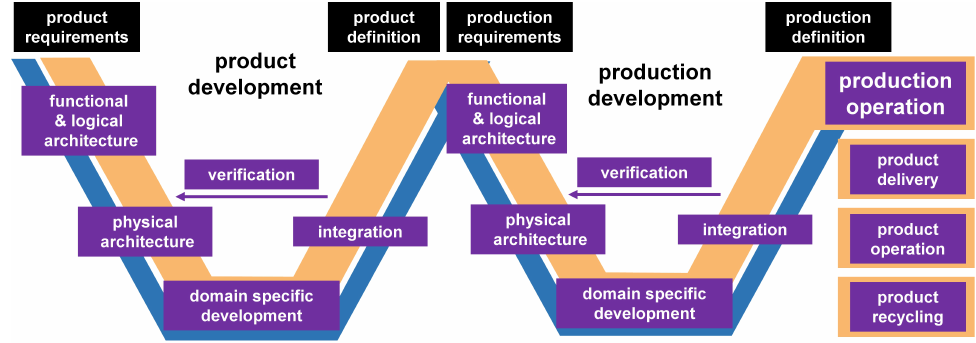
Figure 2. Life-cycle of a product and its production